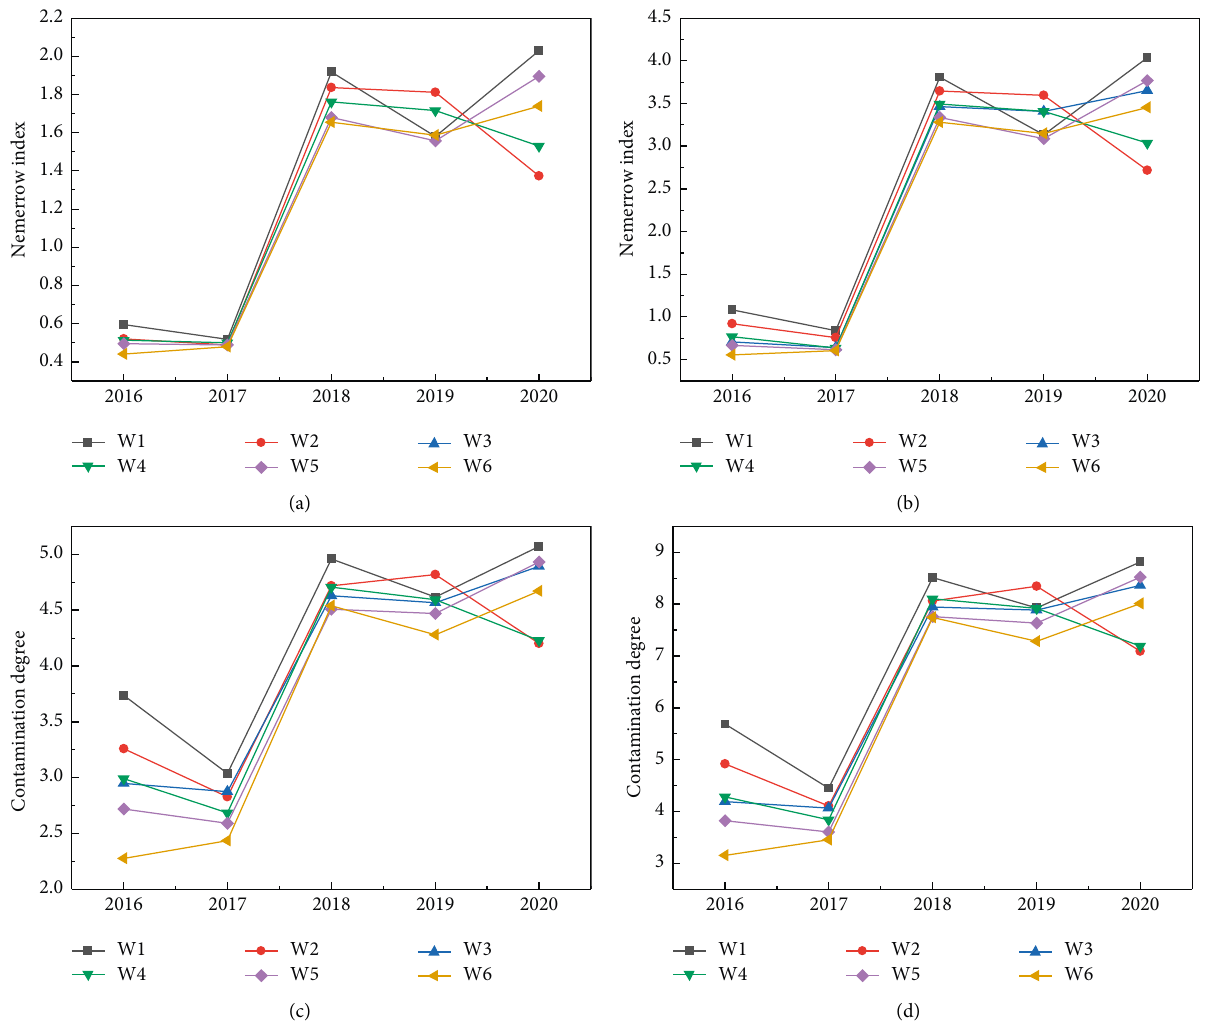
Figure 3: Nemerow index and contamination degree of water in the Ningxia section of the Yellow River during 2016–2020. (a) Nemerow index by using Class III; (b) Nemerow index by using Class II; (c) contamination degree by using Class III; (d) contamination degree by using Class